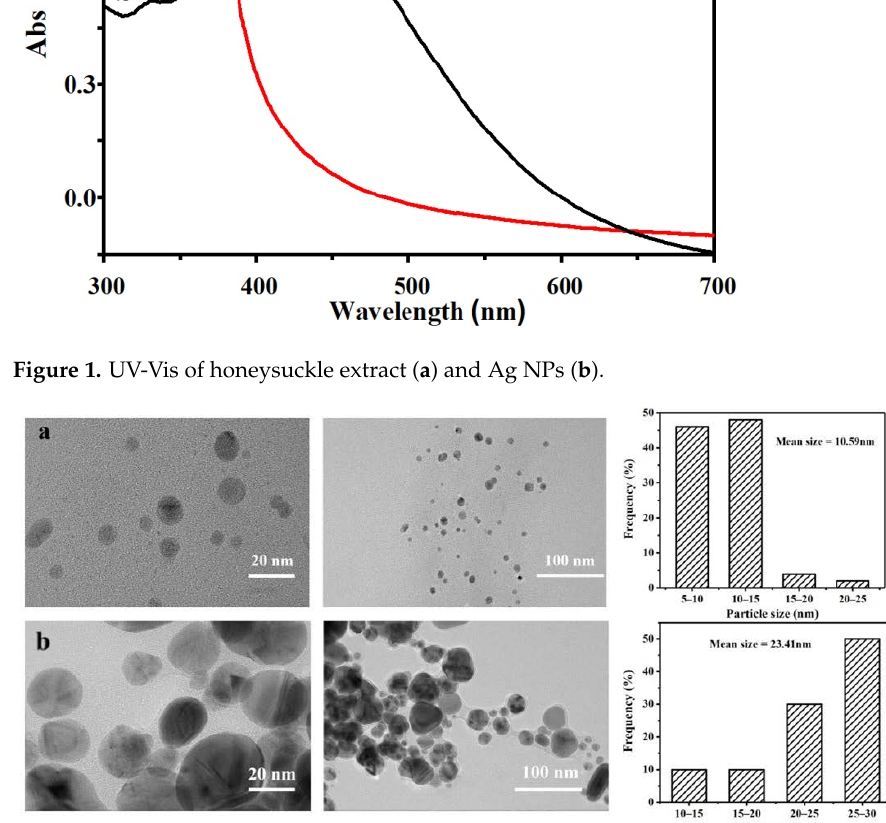
Figure 2. TEM images and particle size distribution of Ag NPs ( a ) and Ag NPs after one month placement ( b